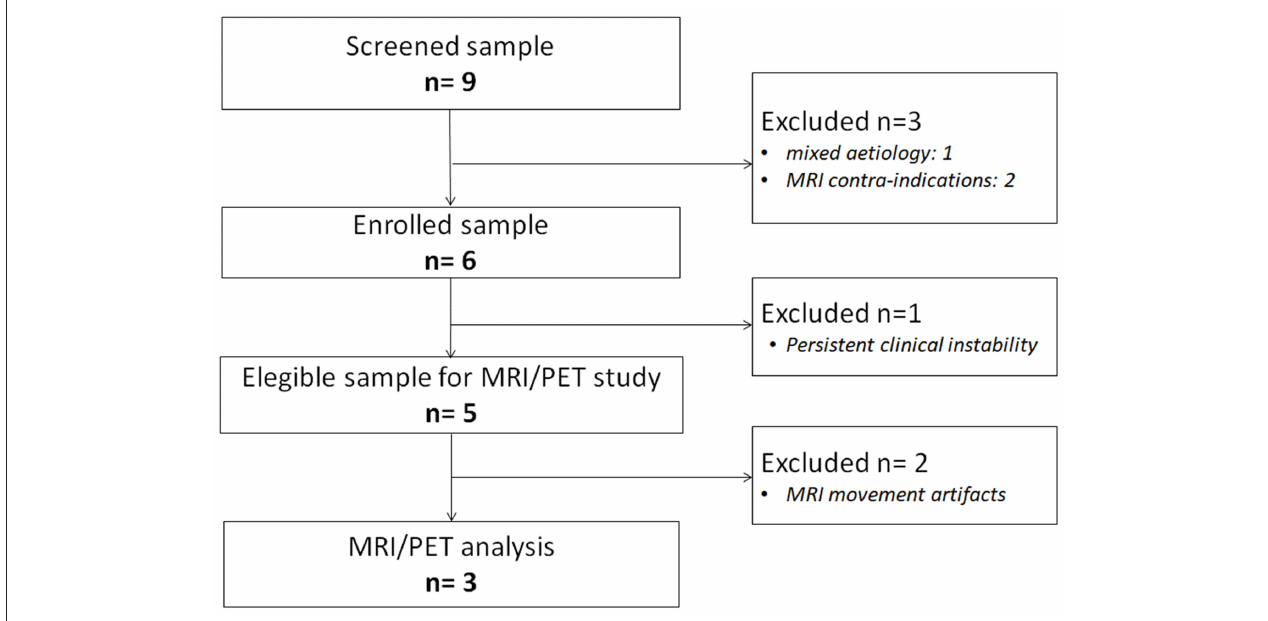
FIGURE 1 | Flow chart of patient selection in each step of the study.